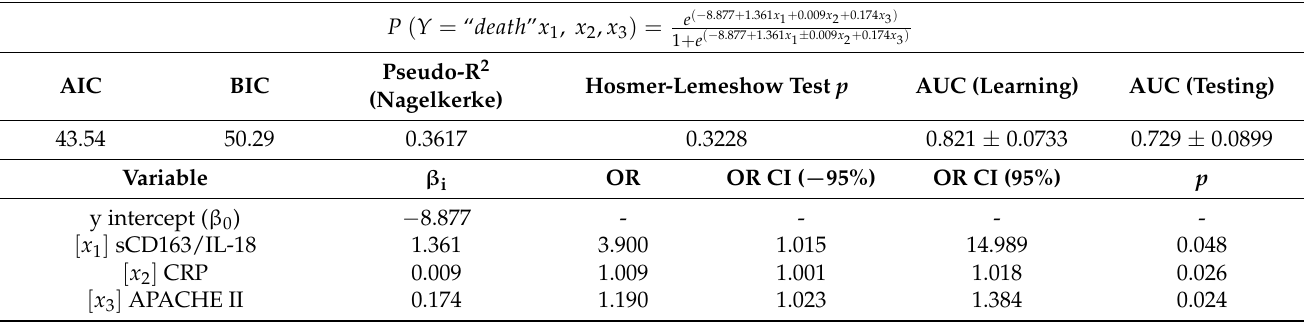
The second model (Table 4: model 2) utilized three features: the sCD163/IL-18 ratio, concentration of CRP and values of the APACHE II score. The predictive power of this model was inferior to model 1 (model 2 testing AUC: 0.792 ± 0.0709), although different insights could be gathered with its use. According to this model, each one-unit increase in the sCD163/IL-18 ratio was associated with approximately a 3.90-fold increase in the odds of death ( p ≈ 0.048). Moreover, one-unit increases in values of CRP or APACHE II would increase the odds of death by 0.90% ( p ≈ 0.026) or 19.0% ( p ≈ 0.024), respectively. According to the receiver operating characteristic (ROC) analysis (Table A4), the most optimal P(Y) cut-off value for model 1 (Table 4: model 1) was 0.124, yielding 100% sensitivity and 55.2% specificity. The most optimal P(Y) cut-off value for model 2 (Table 4: model 2) was 0.217; sensitivity and specificity were 0.909 and 0.655, respectively. Interestingly, not only the values of the sCD163 concentration (as shown in the logistic regression model, Table 4), but also the change of this concentration over the five days from ICU admission (Table 5, Figure 2) are probably associated with in-hospital mortality. A significant difference between non-survivors and survivors in sCD163 concentration was observed during each of three analyzed timepoints ( p -values approximately 0.017, 0.0005 and 0.0001 for timepoints 1st day, 3rd day and 5th day, respectively). A five-day decrease in the sCD163 concentration was observed in survivors, whereas most of the patients who were about to die showed an increase in these values. Such an association was not inferred in case of IL-18 concentration